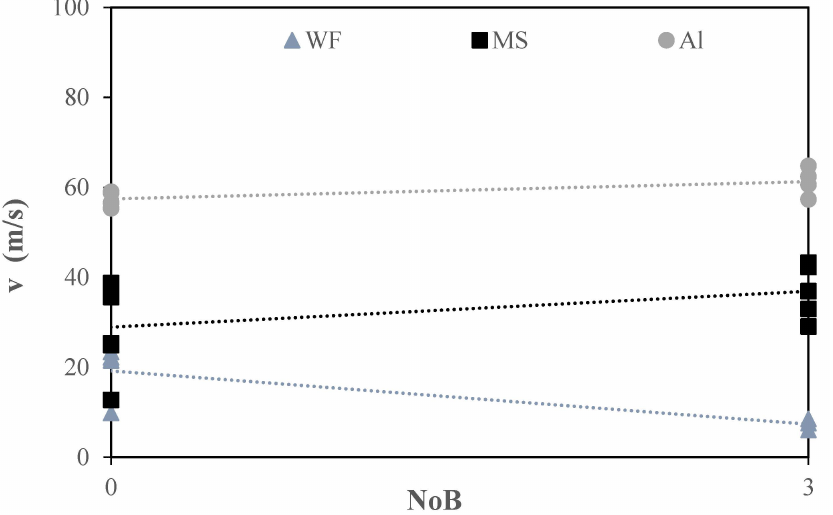
Figure 4. Influence of bends (R/D ratio 0.6) on flame speed between position 1 and 2 for each dust.